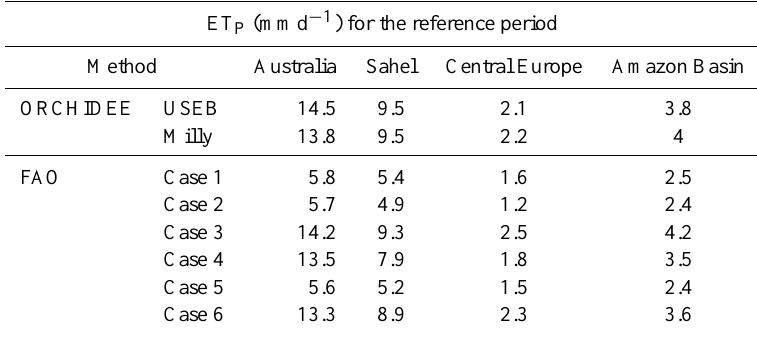
Table 3. Mean ET P for the reference period regarding the USEB and Milly methods, as well as the FAO’s six cases. ET P (mmd − 1 ) for the reference period